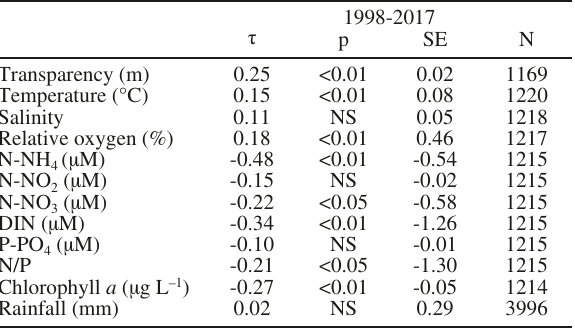
Table 2. – Seasonal Kendall test of the hydrochemical parameters and rainfall data: τ values ( τ ), significance of trend (p),